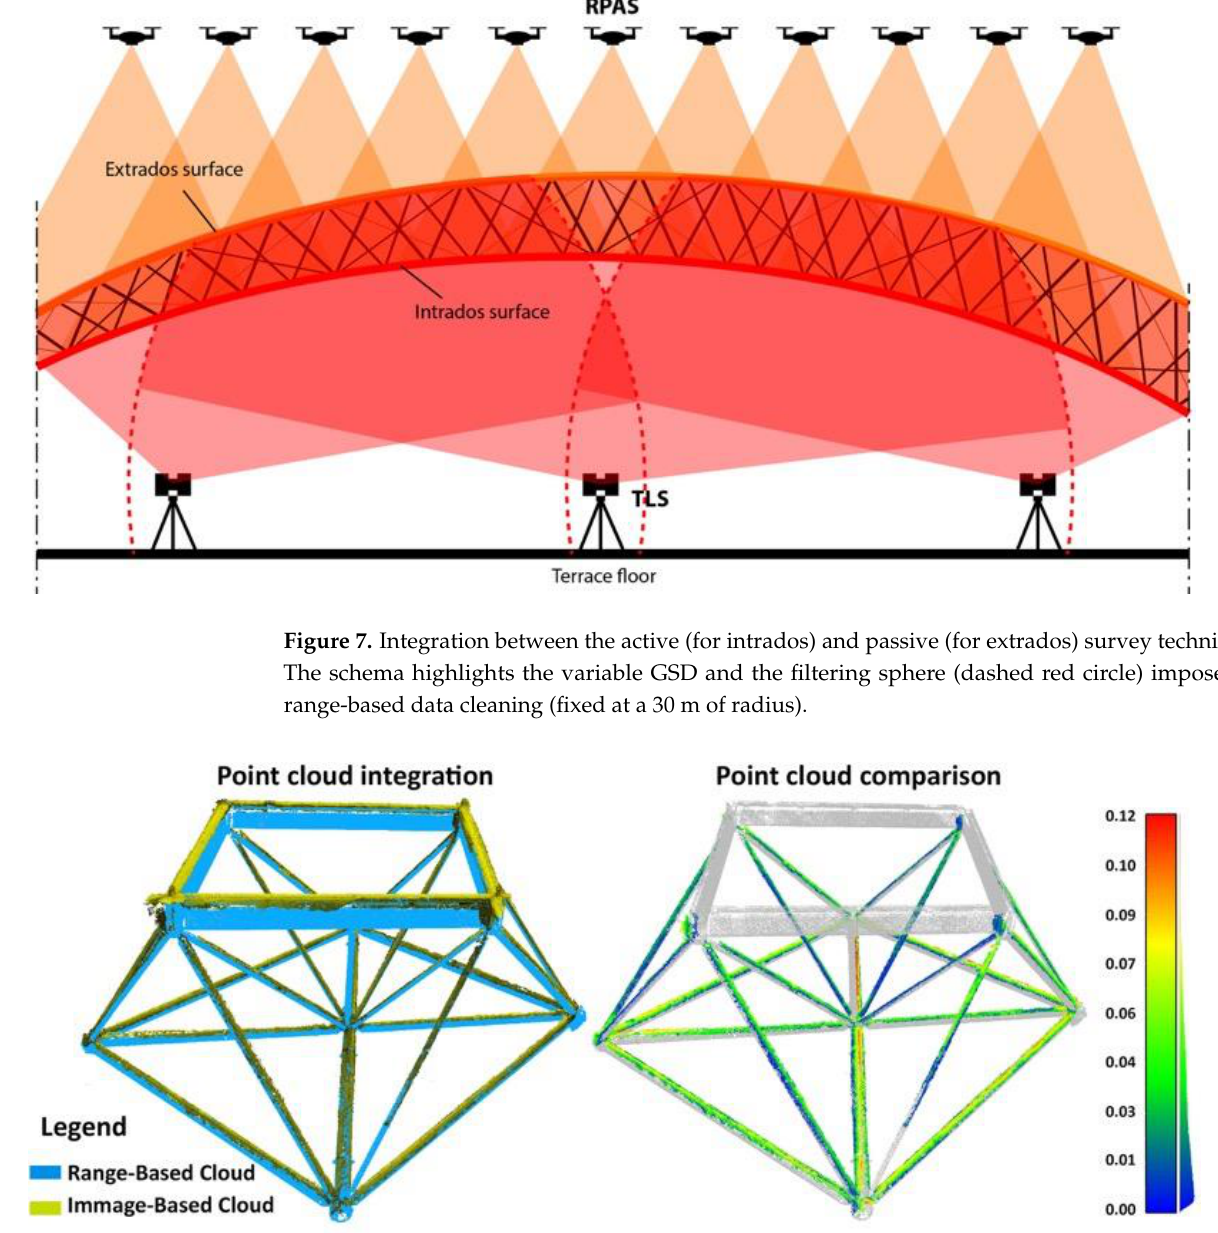
Figure 8. Comparison of a single mesh between range-based and image-based data with relative integration between the two systems. Outliers without overlap were excluded from the comparison.